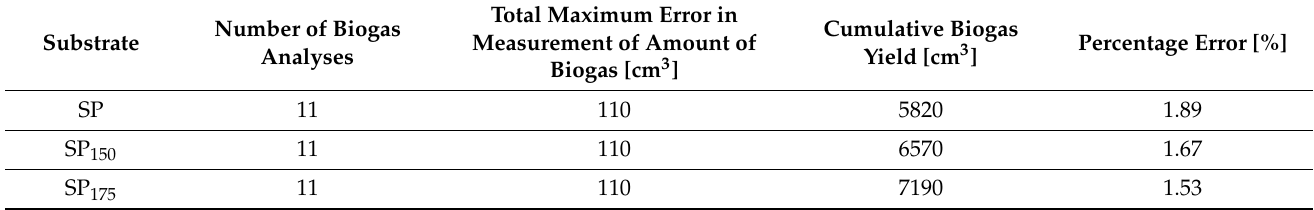
Table 13. The maximum errors of the cumulative amount of